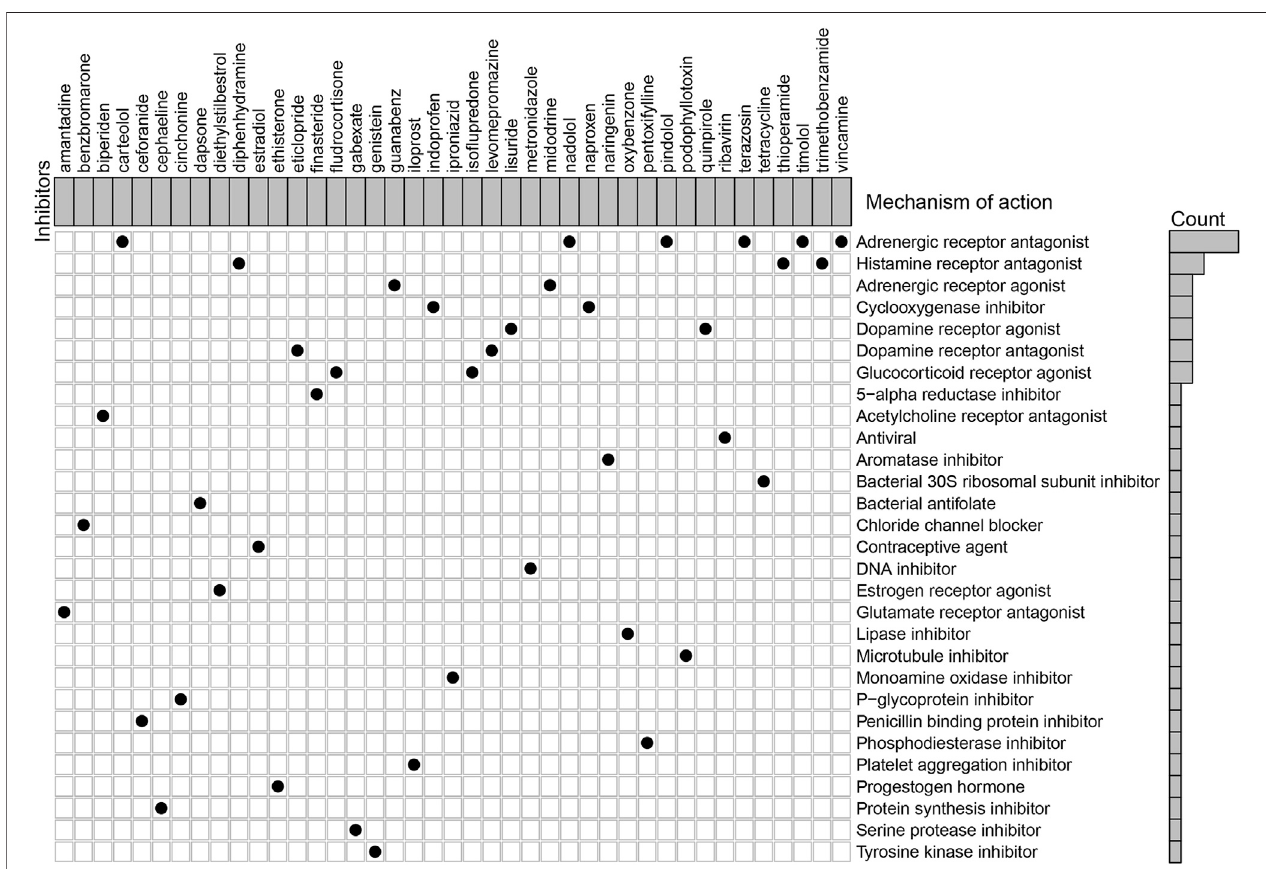
FIGURE 7 | Explorations of candidate drugs targeting the immune-related lncRNA pair signature for the treatment of GC by Connectivity Map analysis.